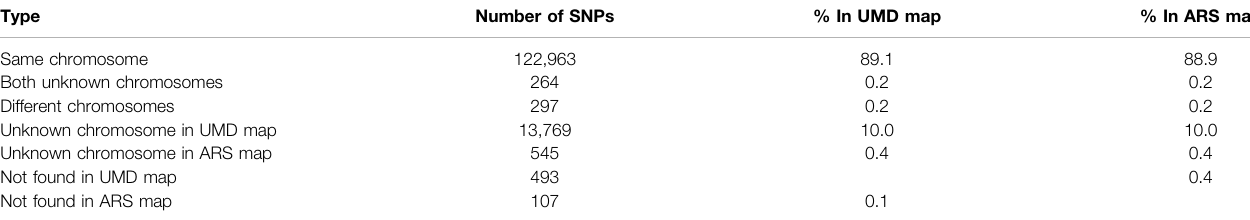
TABLE 1 | Summary of the difference of single-nucleotide polymorphism (SNP) number between UMD 3.1 and ARS 1.2 assemblies.